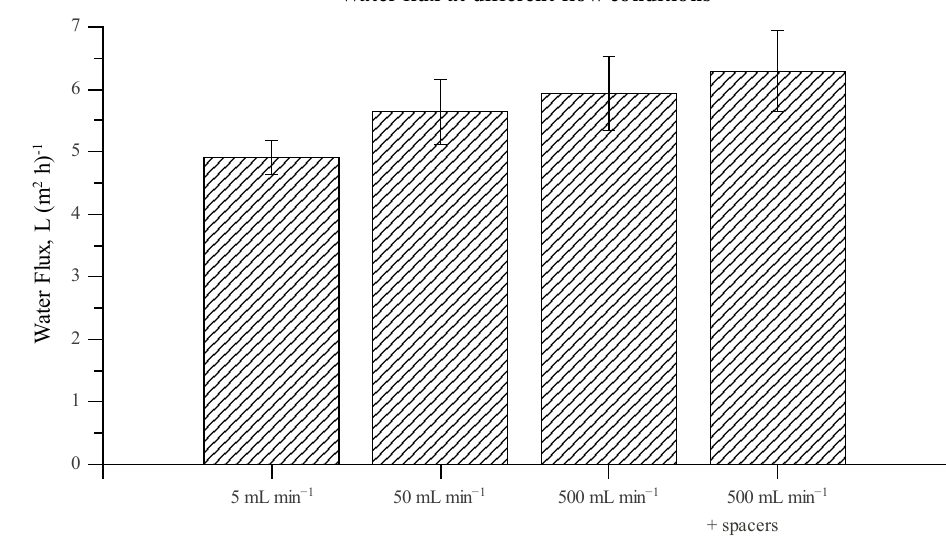
The obtained membrane parameters are summarized in Table 1. These are the values used in all CFD simulations. Table 1. Experimentally determined membrane parameters. i refer to the number